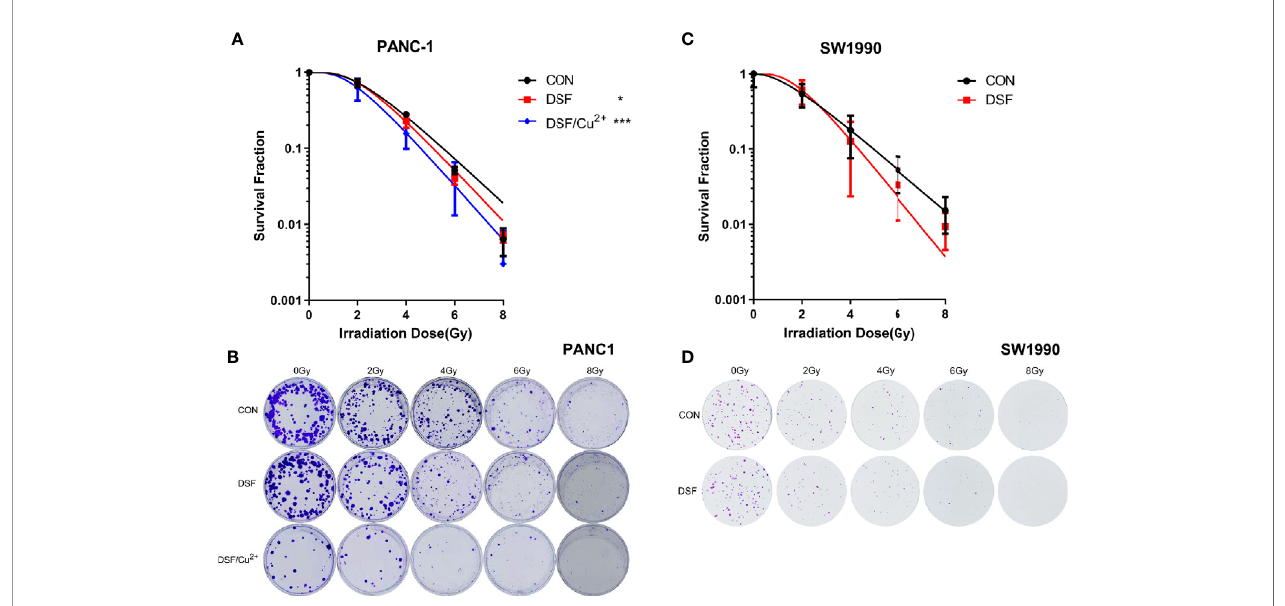
FIGURE 2 | DSF increases the radiosensitivity of pancreatic cells. PANC-1 and SW1990 cells were pretreated with or without 15 m M DSF and DSF (15 m M)/Cu 2+ (1 m M) for 24 h and then exposed to 2, 4, 6 or 8 Gy of X-ray radiation. After an additional incubation for 14 days, the clones were fi xed with 4% paraformaldehyde, stained with crystal violet, and counted. The survival fraction was calculated, and the survival curve was then generated based on the “ single-hit multitarget ” formula (SF=1 - [1 - exp (-D/D 0 )] N, D q =D 0 lnN). (A, C) Survival curve of the colony formation assay of PANC-1 and SW1990 cells. (B, D) Representative images of colony formation. Data were obtained from 3 independent experiments, and statistical analyses were performed using one-way ANOVA. *p < 0.05, ***p < 0.001.